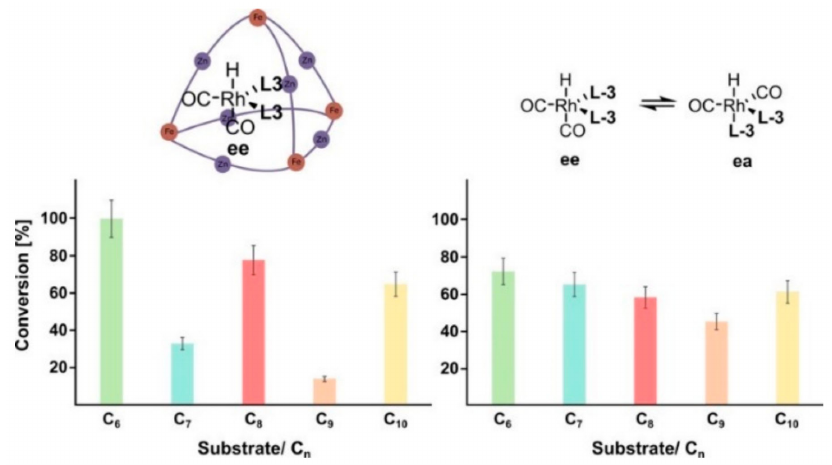
Figure 10. Conversion values obtained in the hydroformylation of alkenes with the nanocatalyst 48 ( left ) and in the bulk solution ( right ) (reproduced from Ref. [47], with permission of John Wiley and